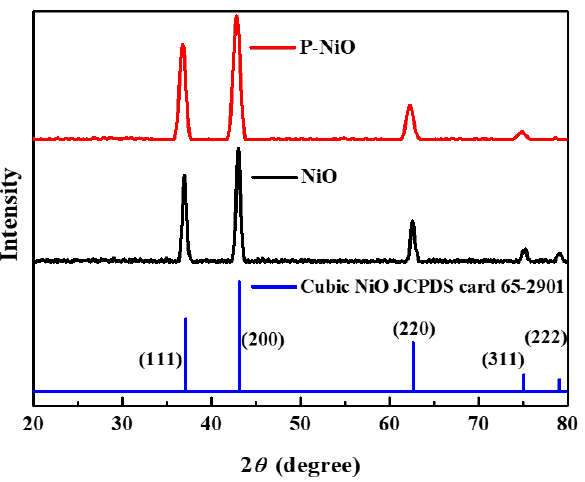
Figure 1. XRD patterns of the P-NiO and NiO.